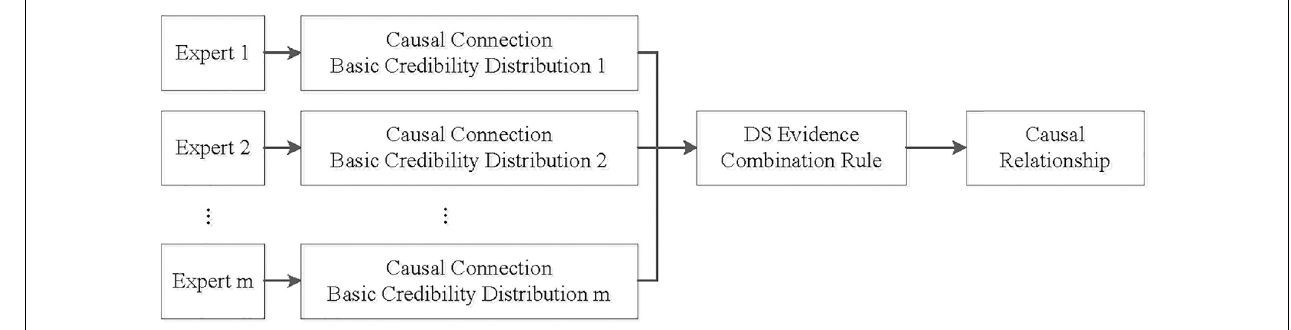
FIGURE 1 | Knowledge fusion for BN structure learning.